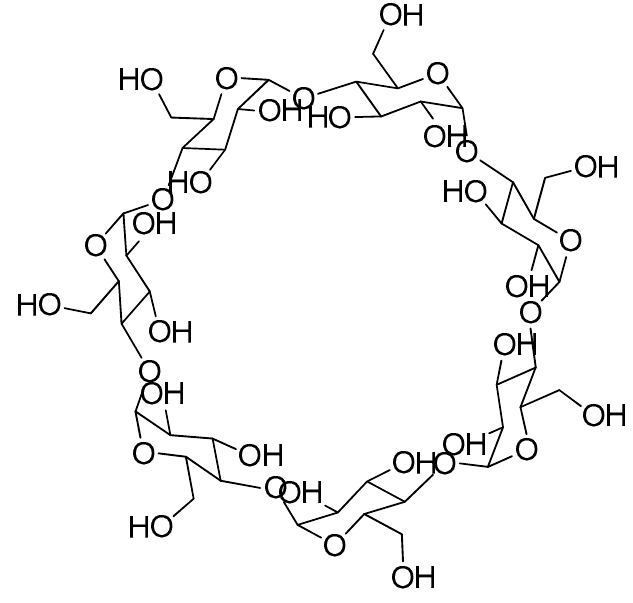
Figure 13. Chemical structure of β -CD.